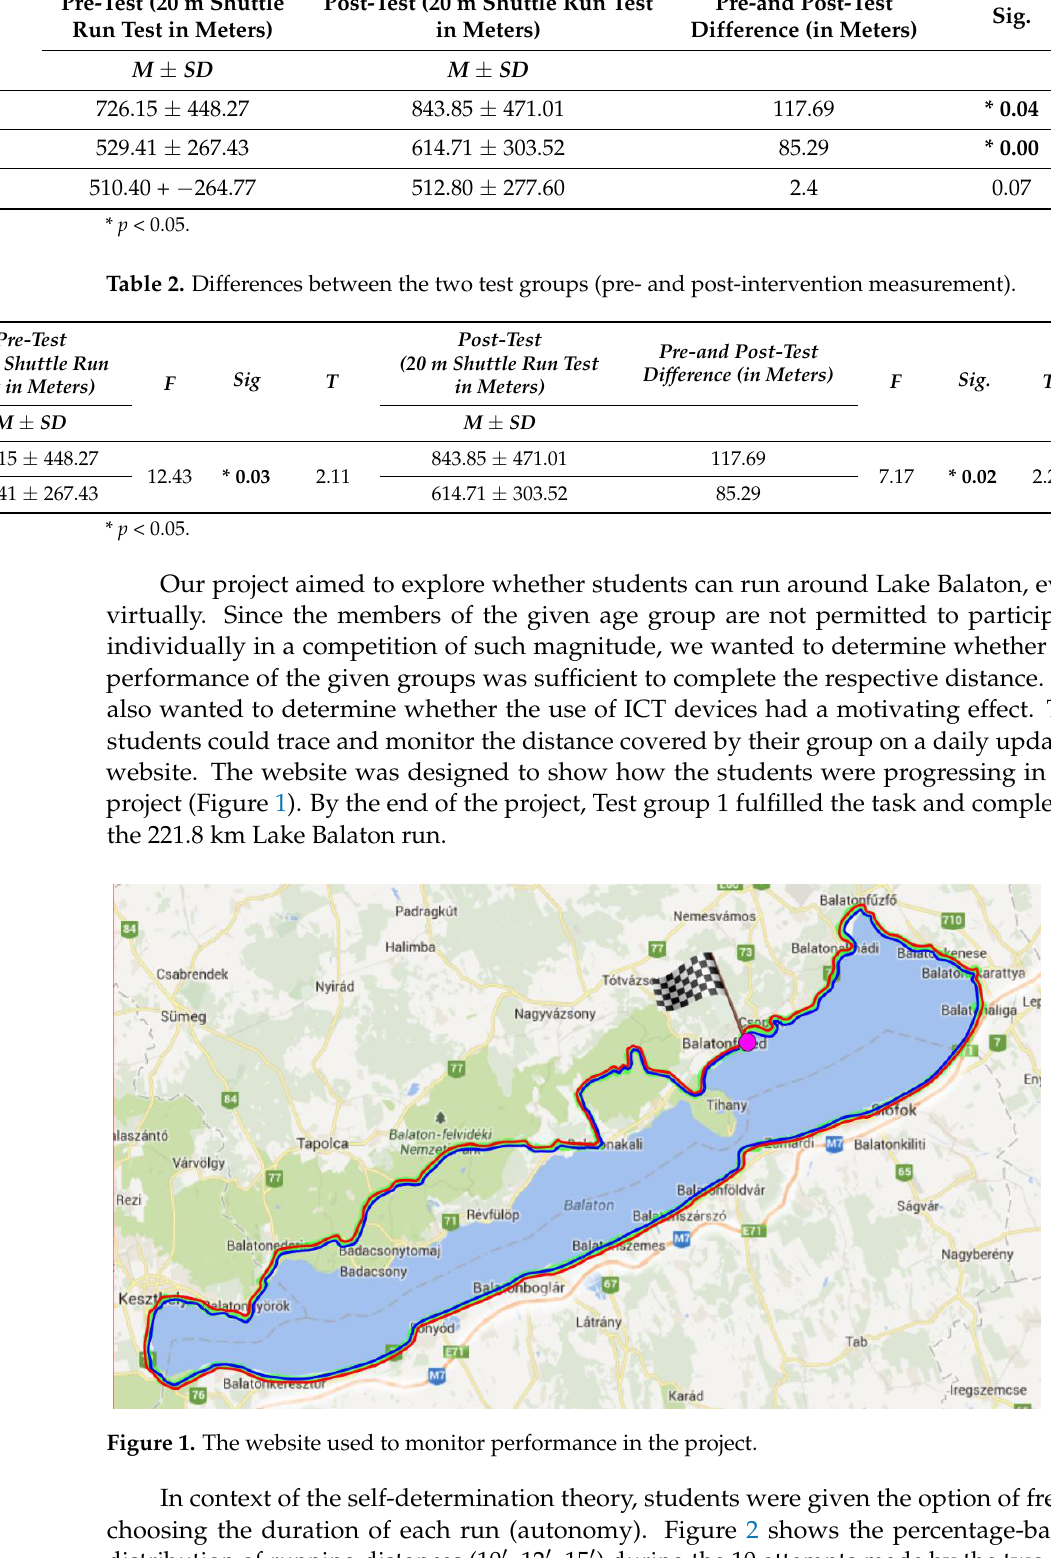
Table 1. A group-based breakdown of student performance prior to and after intervention.